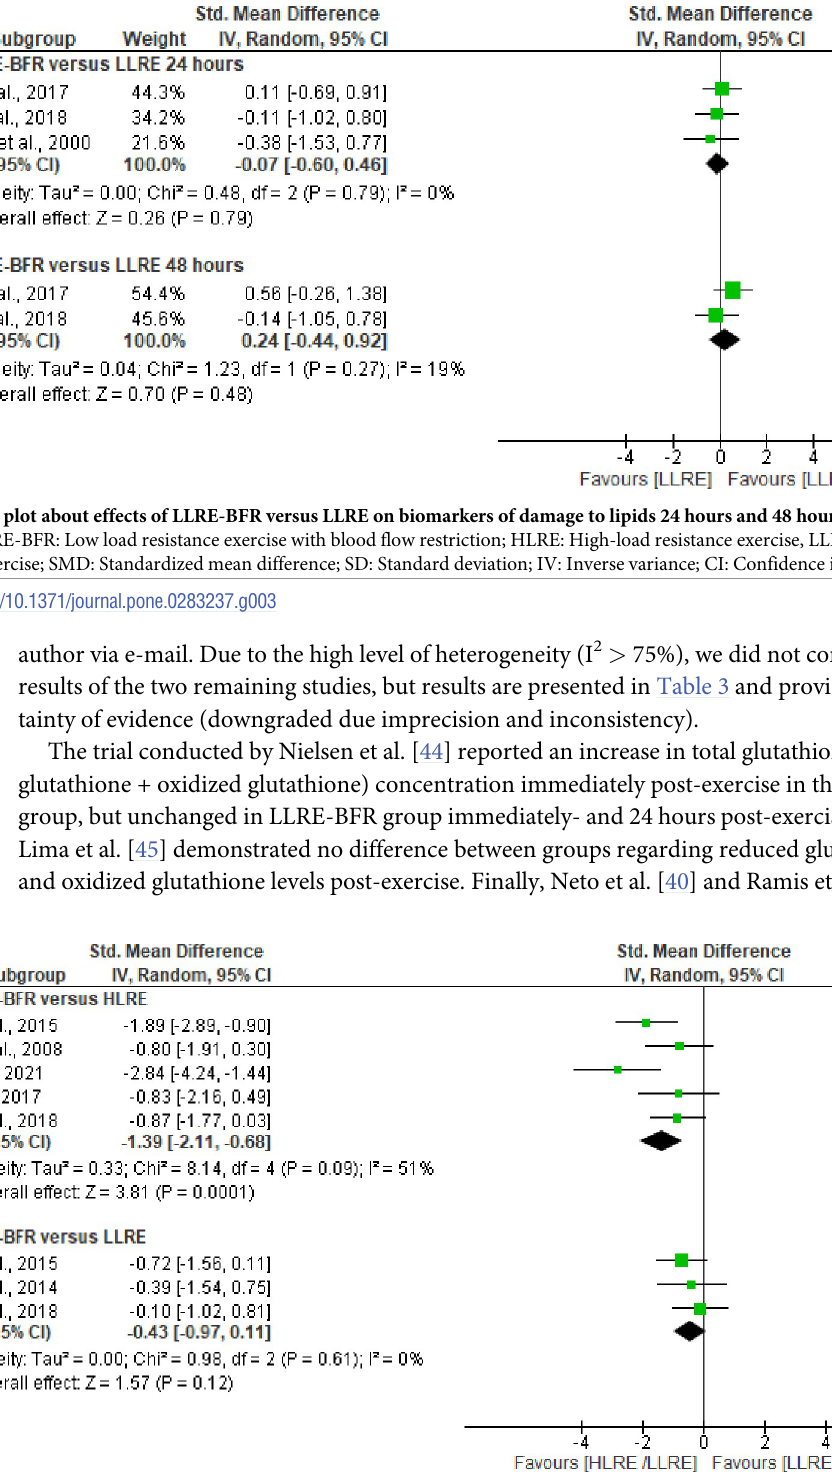
Fig 4. Forest plot about effects of LLRE-BFR versus HLRE and LLRE on biomarkers of damage to proteins post-exercise. LLRE-BFR: Low load resistance exercise with blood flow restriction; HLRE: High-load resistance exercise, LLRE: Low load resistance exercise; SMD: Standardized mean difference; SD: Standard deviation; IV: Inverse variance; CI: Confidence interval.